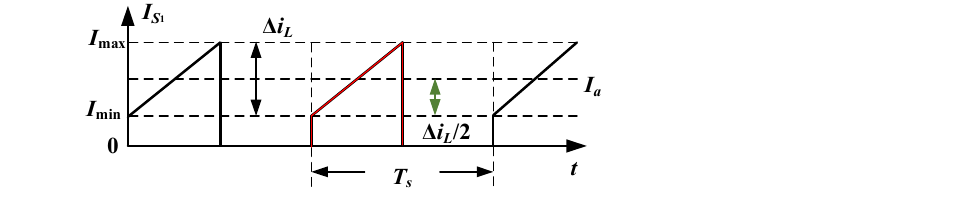
Figure A1. The current waveform of S 1 for I min > 0 (without ZVS).